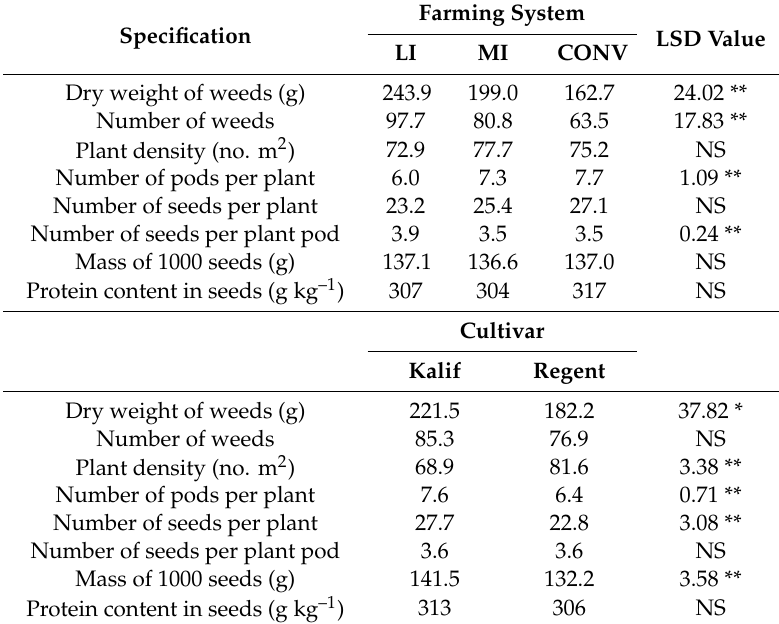
Number of seeds per plant NS Number of seeds per plant pod Protein content in seeds (g kg –1 ) 307